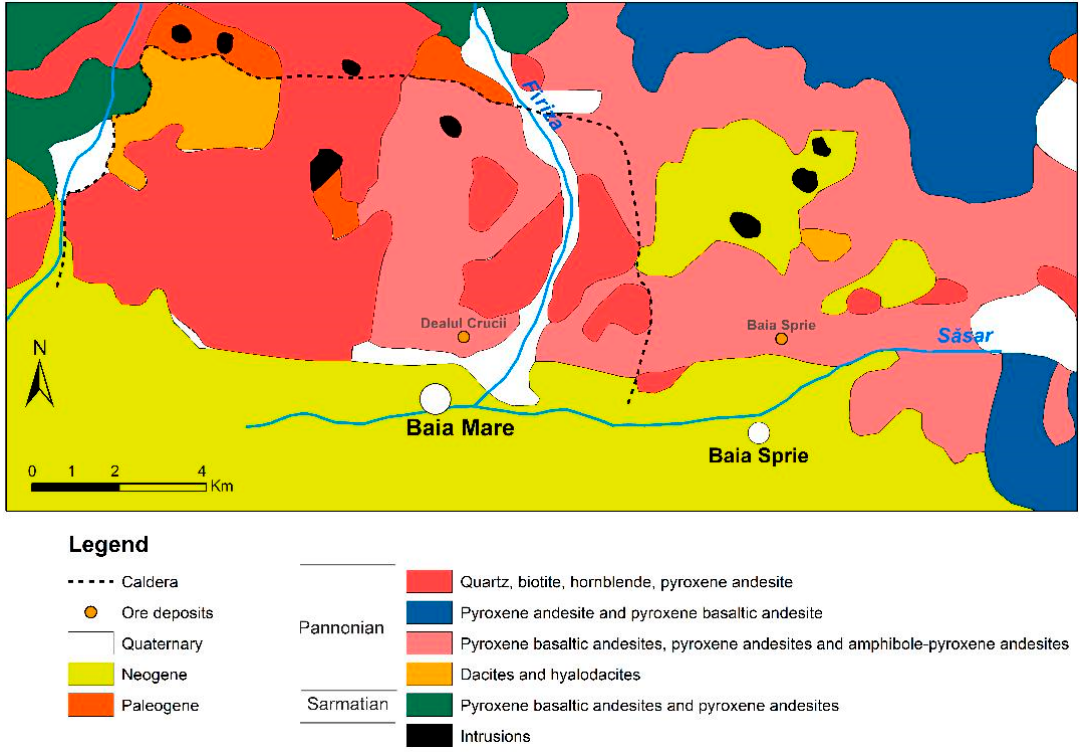
Figure 1. Sketch of the map of Baia Mare area with the location of ore deposits Dealul Crucii and Baia Sprie, with modifications after [1].